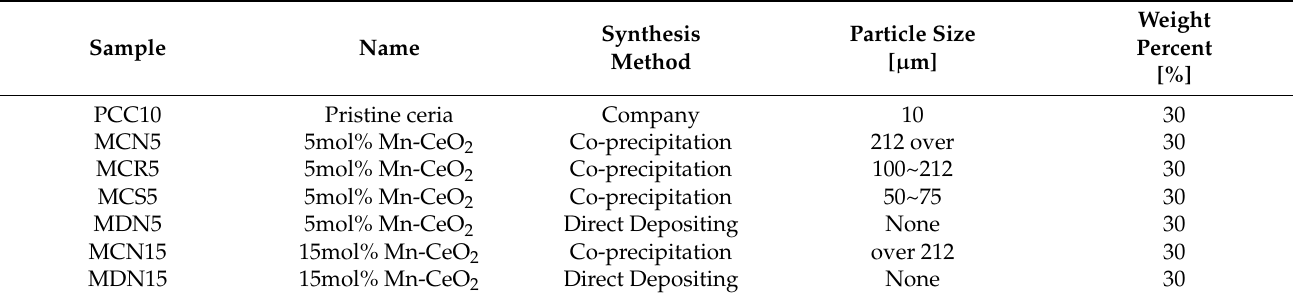
Table 1. Sample names and specifications of synthesis method, dopant extent, particle size, and weight percent of the seven prepared foam